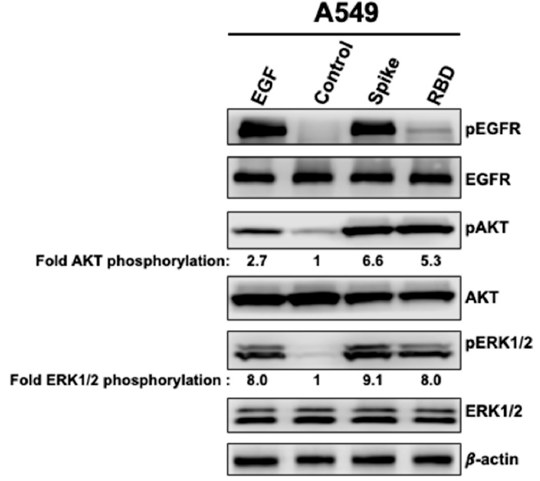
Figure 1. Effect of SARS-CoV-2 Spike 1 protein on epidermal growth factor receptor (EGFR), Ak strain transforming (AKT) and extracellular signal-regulated kinase 1/2 (ERK1/2) activation. A549 cells were treated or not with EGF (5 µg/mL) for 15 min or with full-length Spike 1 (2.5 µg/mL) or with the spike receptor-binding domain (RBD) (5 µg/mL) protein for 5 min then whole-cell extracts were subjected to western blot analysis for phosphoEGFR (pEGFR), phosphoAKT (pAKT), phosphor ERK1/2 (pERK1/2) and their respective total levels.